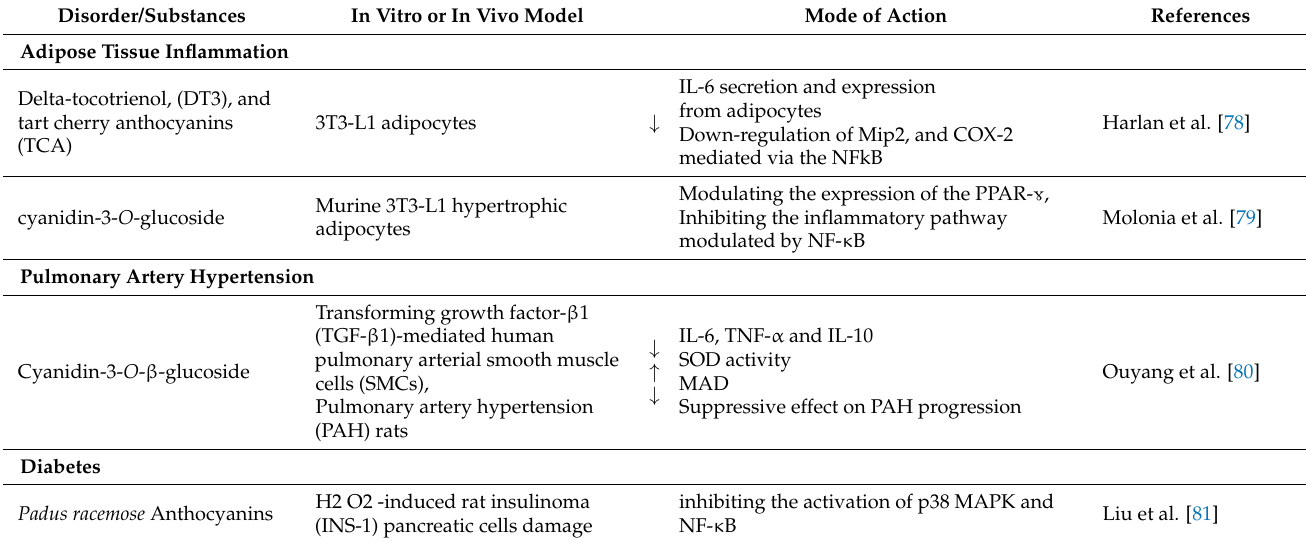
Table 2. In vivo and in vitro research update (studies published in 2020) on anthocyanins and their anti-inflammatory effects in pathological